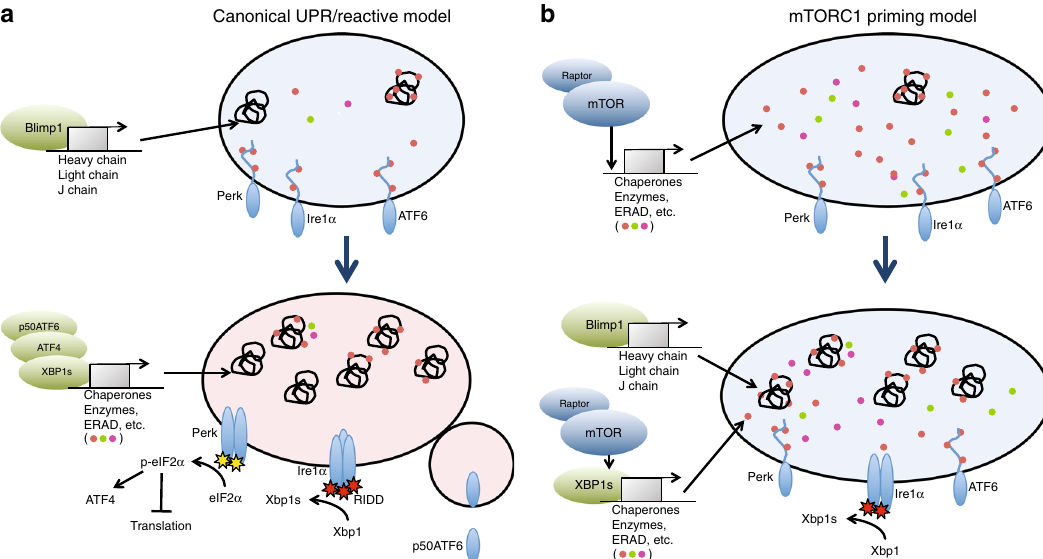
Fig. 8 Model for mTORC1 priming of the ER preceding plasma cell differentiation. a The conventional model for ER remodeling during plasma cell differentiation holds that Blimp1-mediated increases in immunoglobulin expression causes the chaperone BiP to release from the luminal tails of IRE1 α , allowing it to dimerize and mediate Xbp1 mRNA splicing. In this model Xbp1s is the main effector of ER remodeling. Paradoxically, with this scenario activation of PERK and ATF6 would occur by the same mechanism, causing translation inhibition and increased chance of apoptosis downstream of PERK activation. b Revised model wherein, preceding Blimp1 induction, mTORC1 signaling facilitates the upregulation of plasma cell-af fi liated UPR genes, including chaperones, ERAD machinery, and enzymes necessary for enhancing protein secretion. The resulting “ primed ” ER is then better equipped to handle increased protein load following Blimp1 induction. At this point the UPR is tuned so that we see activation of the Xbp1-splicing activity of IRE1 α without RIDD activity and activation of